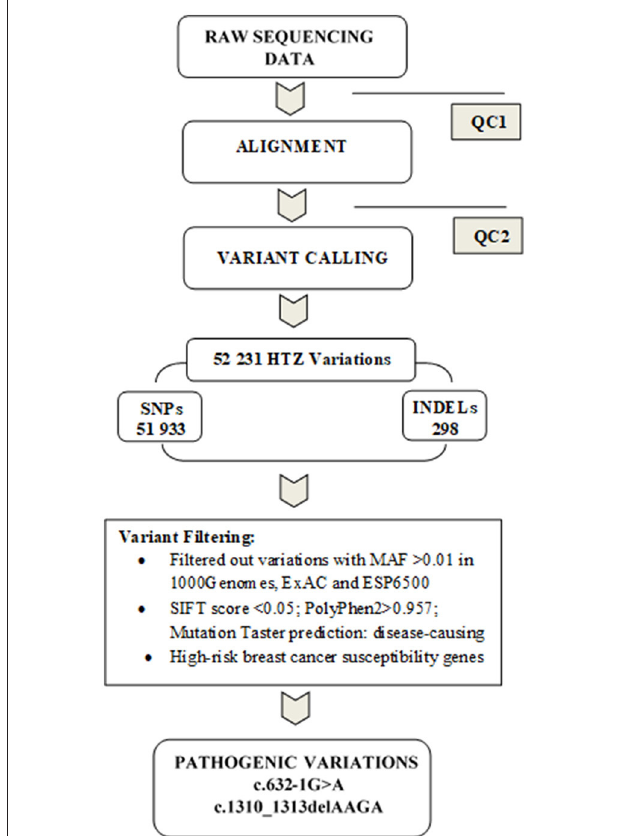
FIGURE 1 | Summary of the data analysis pipeline followed in the present study. Before proceeding to the alignment phase, quality control (QC1) was performed on raw sequencing data in order to ensure that the data are optimal for downstream analyses. A second quality control (QC2) was done on alignment data to reduce the alignment artifacts that could influence the quality of downstream variant calling. Subsequently, variants were filtered by keeping only heterozygous variations and discarding those with MAF > 1% in either Exac, 1,000 genomes or ESP6500. We further removed benign or tolerated variations and focused on genes related to breast cancer susceptibility. Two pathogenic mutations were identified c.632-1G > A and c.1310_1313delAAGA in BRCA2